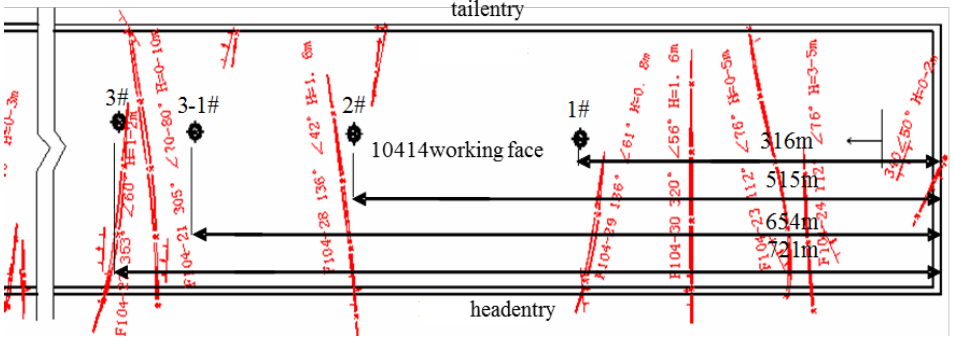
Figure 11. Schematic diagram of the gas drainage drilling arrangement of the 10,414 working face.